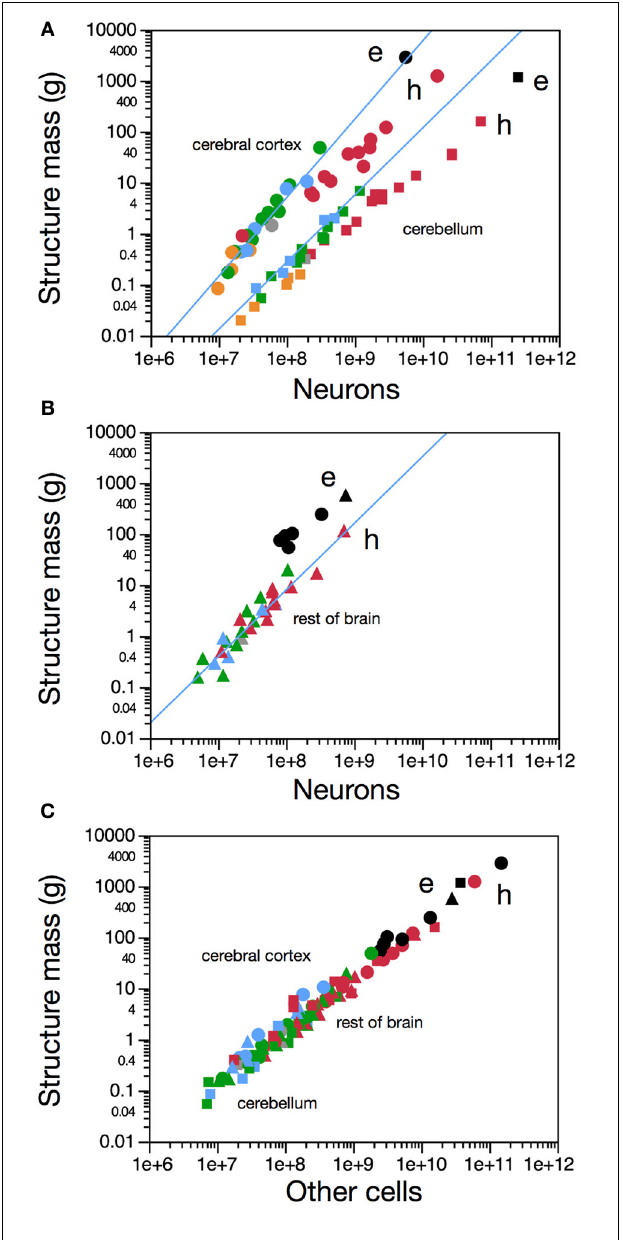
FIGURE 1 | The African elephant brain has as many neurons in the cerebral cortex as expected for an afrotherian of its cortical mass, but more neurons in the cerebellum than expected for its cerebellar mass, and fewer neurons in the remaining brain areas than expected for their mass. In all figures, each data point represents values for both brain sides in one species. (A) Variation in mass of the cerebral cortex (gray and white matter combined; circles) and of the cerebellum (squares) as a function of the number of neurons in the respective structures. (B) Variation in mass of the remaining brain structures as a function of the number of neurons they contain in each species. (C) Variation in mass of cerebral cortex (circles), cerebellum (squares), and remaining brain structures (triangles) across species as a function of their numbers of non-neuronal (other) cells. Elephant data points shown in black (e), other afrotherian species in blue, primates in red (human, h), eulipotyphlans in orange, and glires in green. Data from (Herculano-Houzel et al., 2006, 2007, 2011; Azevedo et al., 2009; Sarko et al., 2009; Gabi et al., 2010; Neves et al., 2014).